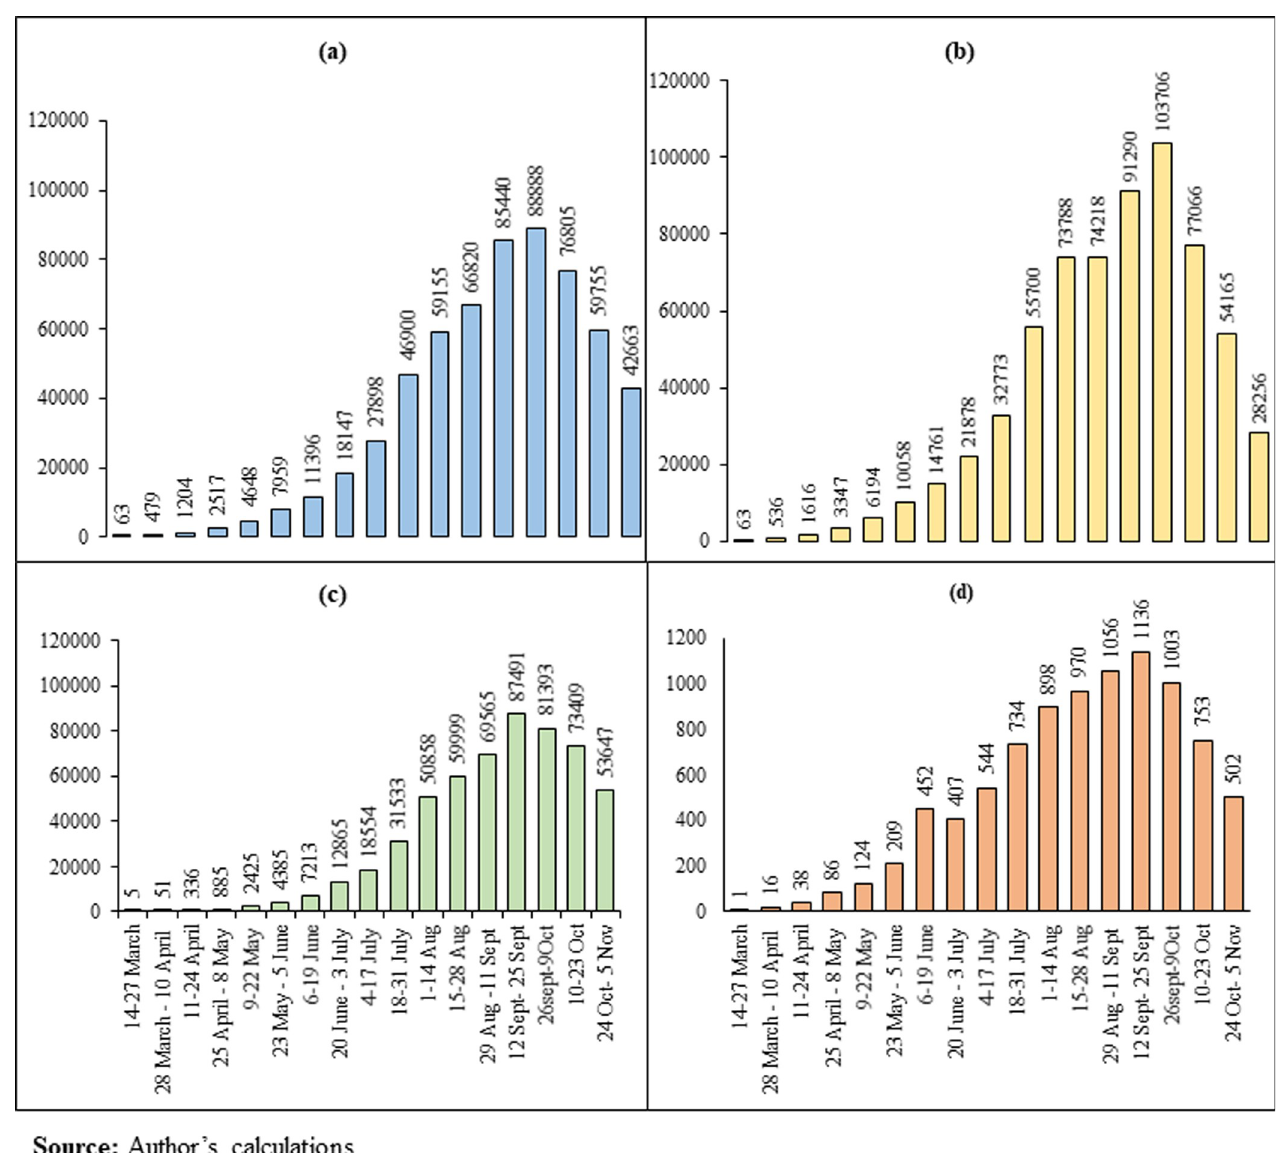
Fig 1. Bi-weekly average new, infected, recovered, deceased cases in India (March 14 –November 5, 2020). (a). Bi-weekly average new cases; (b). Bi-weekly average infected cases bi-weekly; (c). Bi-weekly average recovered cases; (d). Bi-weekly average deceased cases.